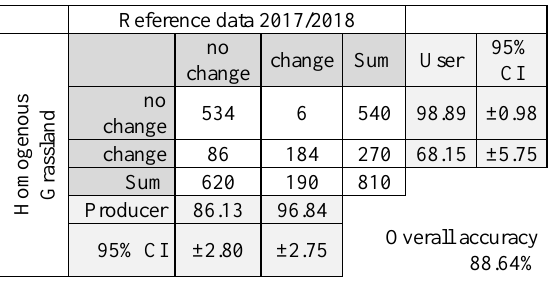
Table 4 . Confusion matrix for Homogeneous grassland. Mainly the changes in “Homogenous Grassland” are detected correctly. Frequent changes can be observed towards crop land